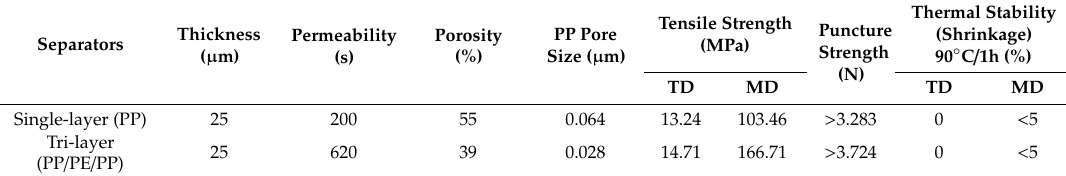
Table 1. Fundamental properties of single-layer polypropylene (PP) and tri-layer polypropylene / polyethylene / polypropylene (PP / PE / PP) separators [26–28].